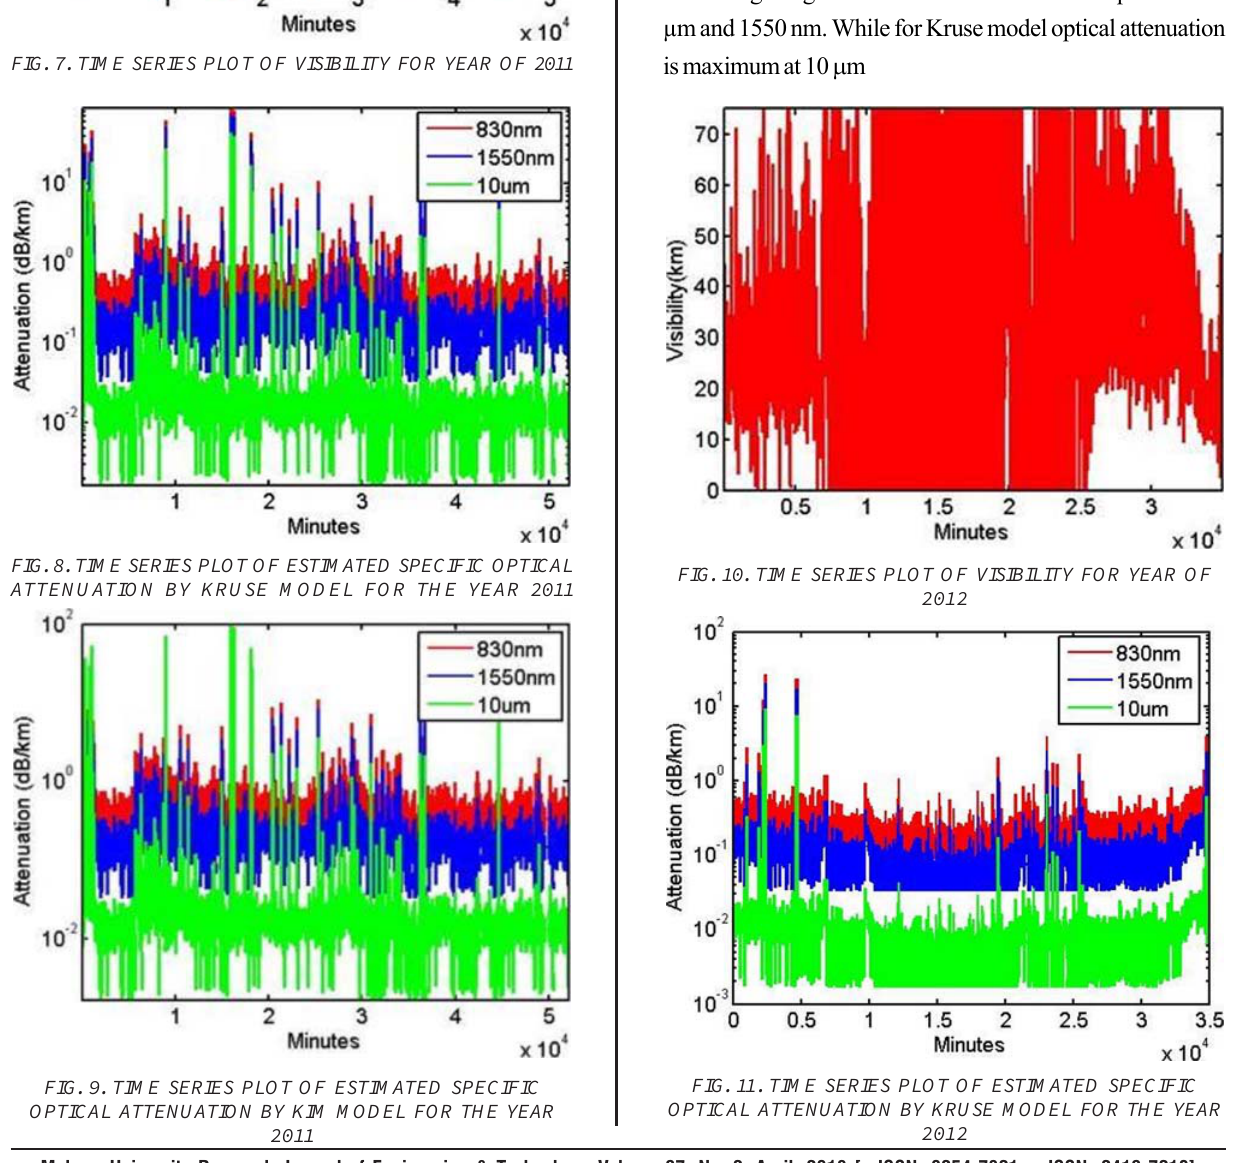
FIG. 11. TIME SERIES PLOT OF ESTIMATED SPECIFIC OPTICAL ATTENUATION BY KRUSE MODEL FOR THE